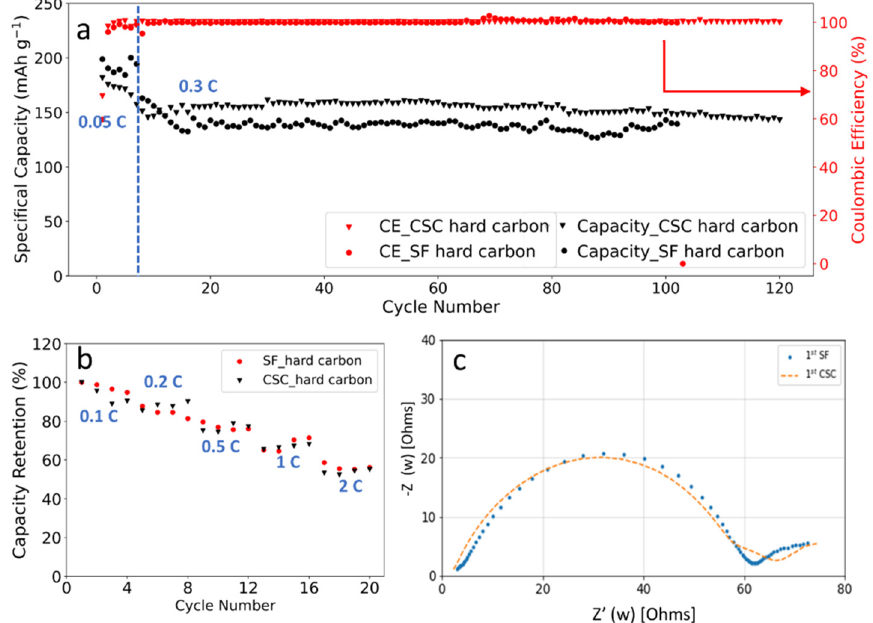
Figure 6. ( a ) Cycling performance and columbic efficiency of the SF hard carbon and CSC electrodes cycled between 0.01 V and 1.5 V; ( b ) rate capability of SF and CSC hard carbon electrodes in the range of 0.1 C to 2 C in half cells; ( c ) EIS analysis of SF and CSC hard carbon electrodes after for- mation.